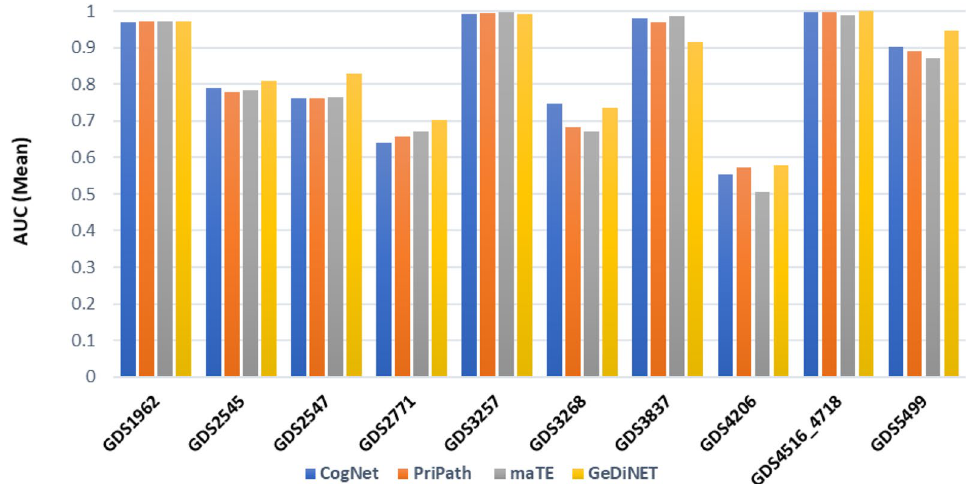
Figure 7. The mean AUC values of GediNET, CogNet, maTE and PriPath for ten different datasets for the top two